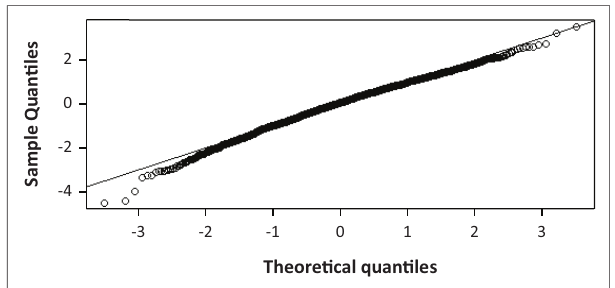
FIGURE 2: Q–Q plot of standardised residuals of asymmetric power auto- regressive conditional heteroscedastic (1,1) model with normal distribution.